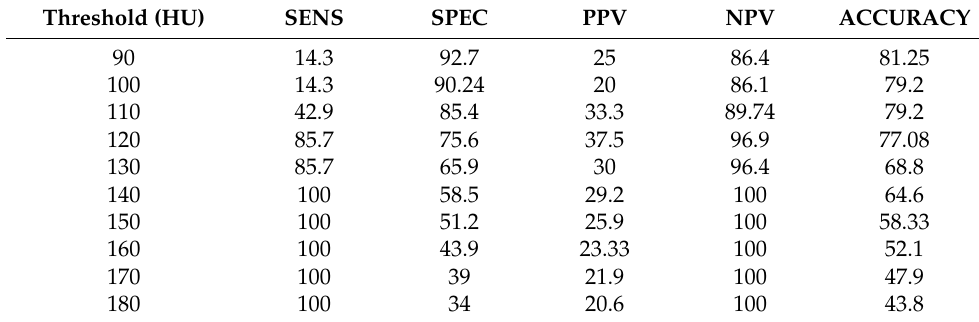
The diagnostic performance of assessment at the L1 vertebral level for diagnosing osteoporosis is shown in Table A4 with a complete record of cut-offs and their sensitivities and specificities positive and negative predictive values. Table A4. Diagnostic performance at L1-osteoporosis/vertebral fractures (DXA T-score ≤ −